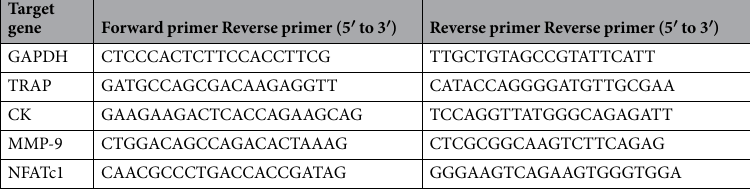
Table 1. Oligonucleotides used for quantitative real-time